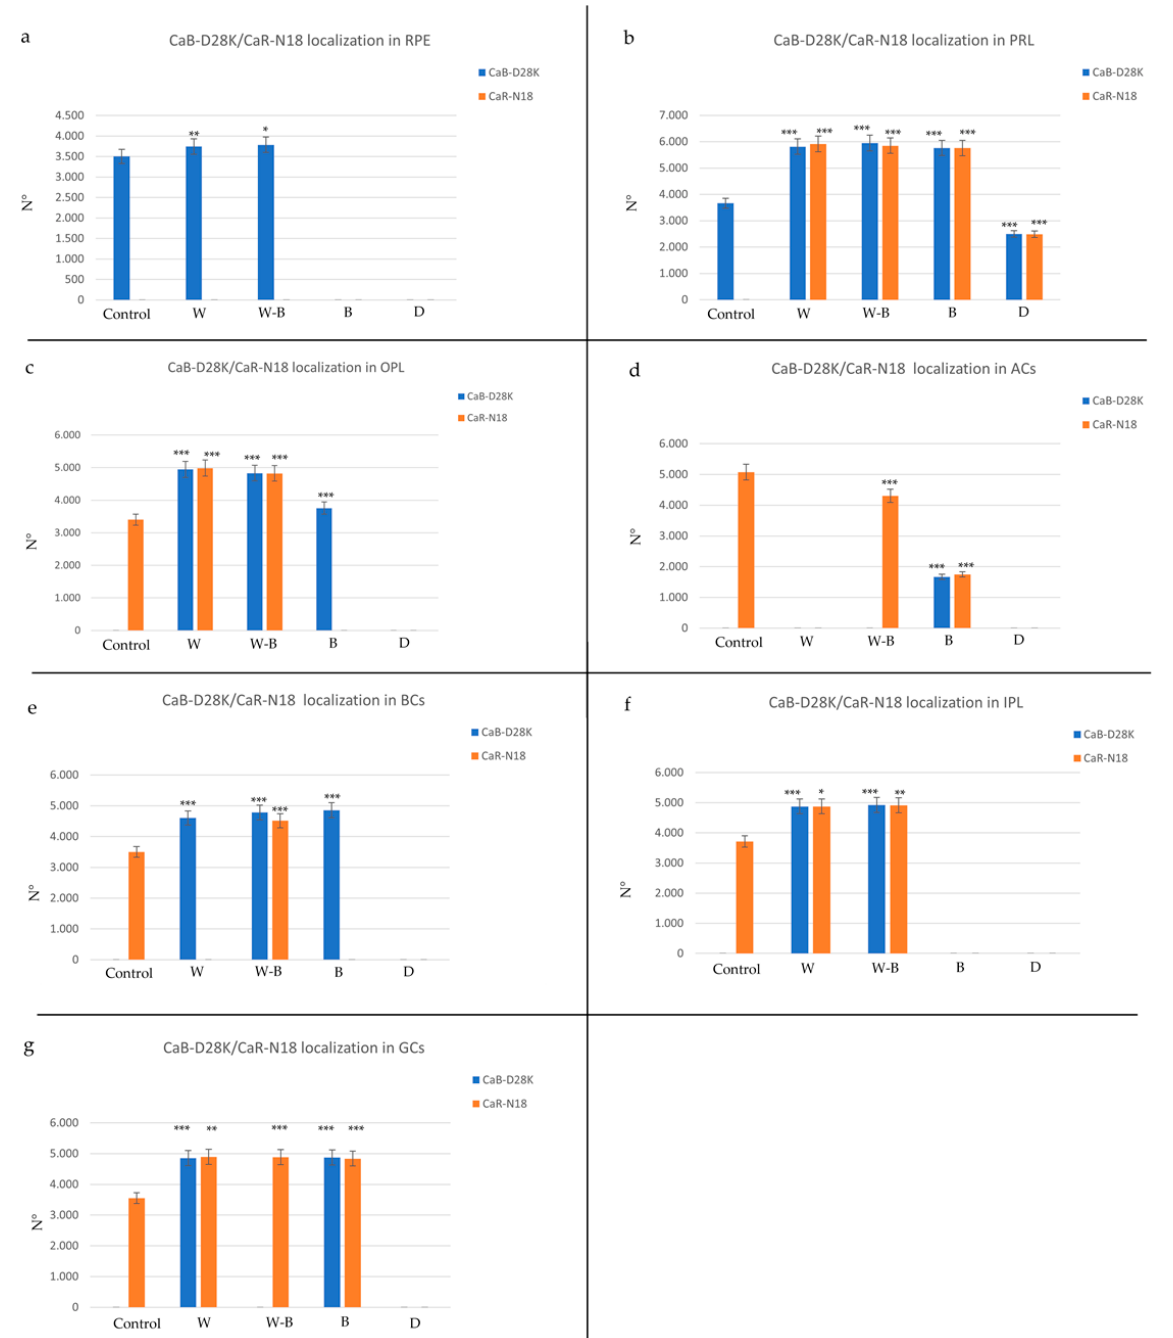
Figure 4. Graphical representation of immunopositivity of: ( a ) retinal pigment epithelium (RPE), ( b ) photoreceptor layer (PRL), ( c ) outer plexiform layer (OPL), ( d ) amacrine cells (ACs), ( e ) inner plexiform layer (IPL), ( f ) bipolar cells (BCs), ( g ) ganglion cells (GCs) detected by Calbindin